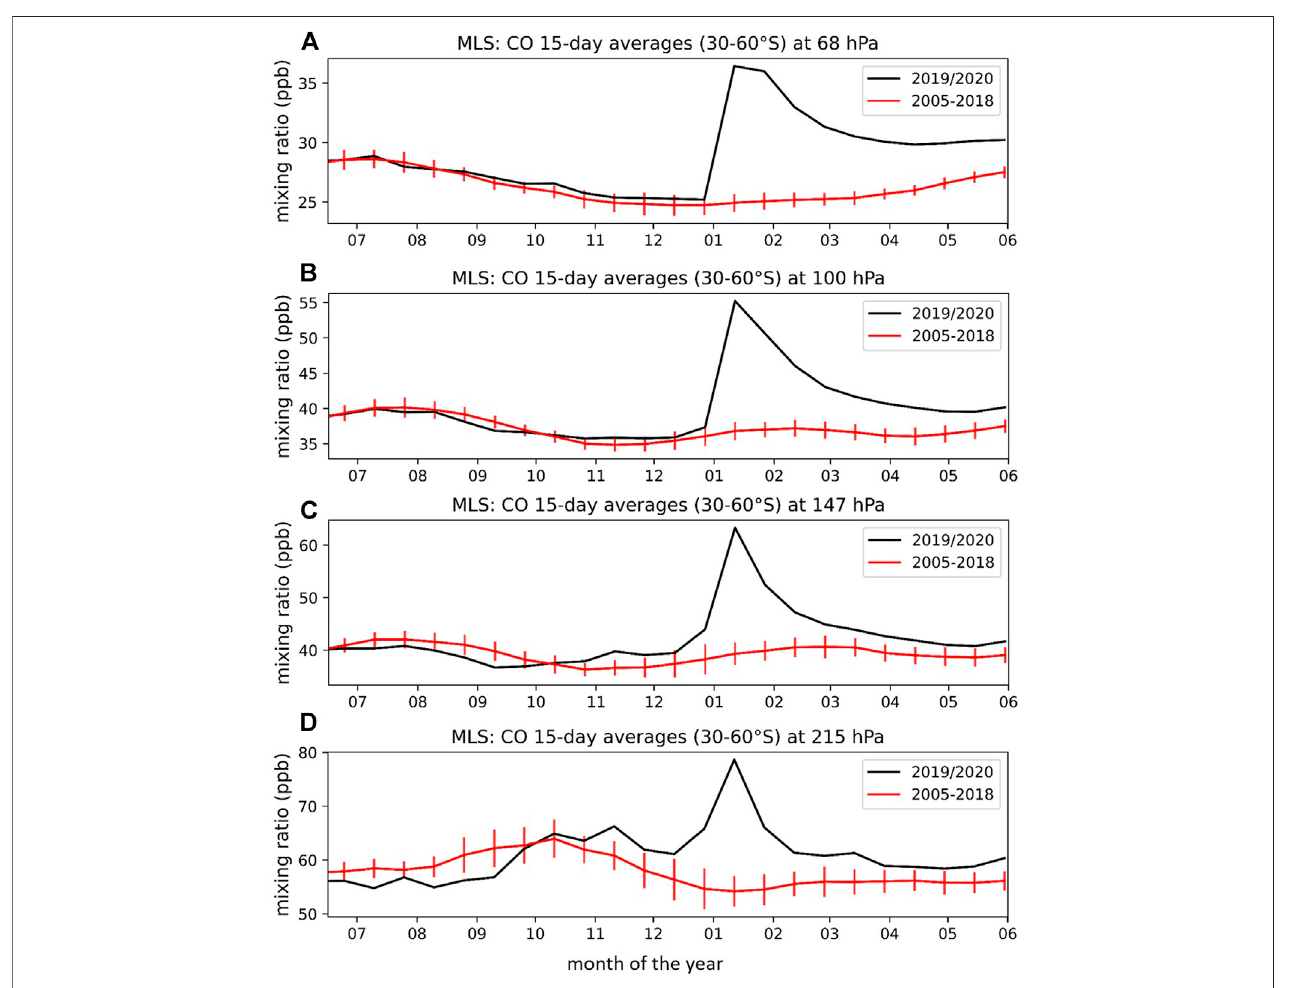
FIGURE 5 | MLS 15-day mixing ratio zonal averages for 2019/2020 (black) and 2005 – 2018 (red, with the respective inter-annual standard deviations) for CO at 68 (A) , 100 (B) , 147 (C) and 215 hPa (D) pressure levels.